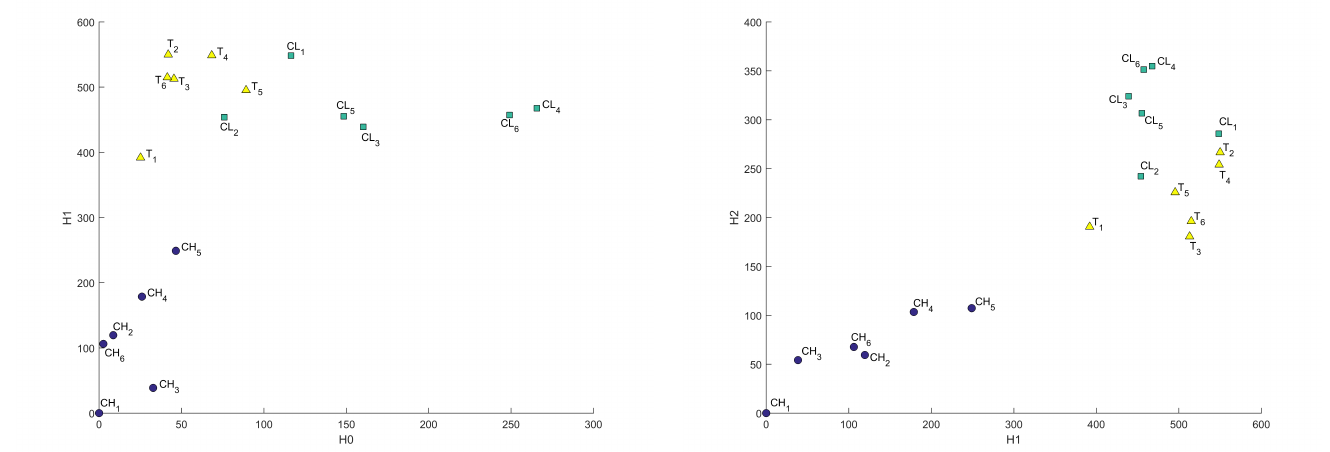
Figure 14. Comparison of 2 classes of C ( CH, CL ) samples with T samples ( T ) in Heat Kernel metric in H 0 – H 1 and H 1 – H 2 coordinates.